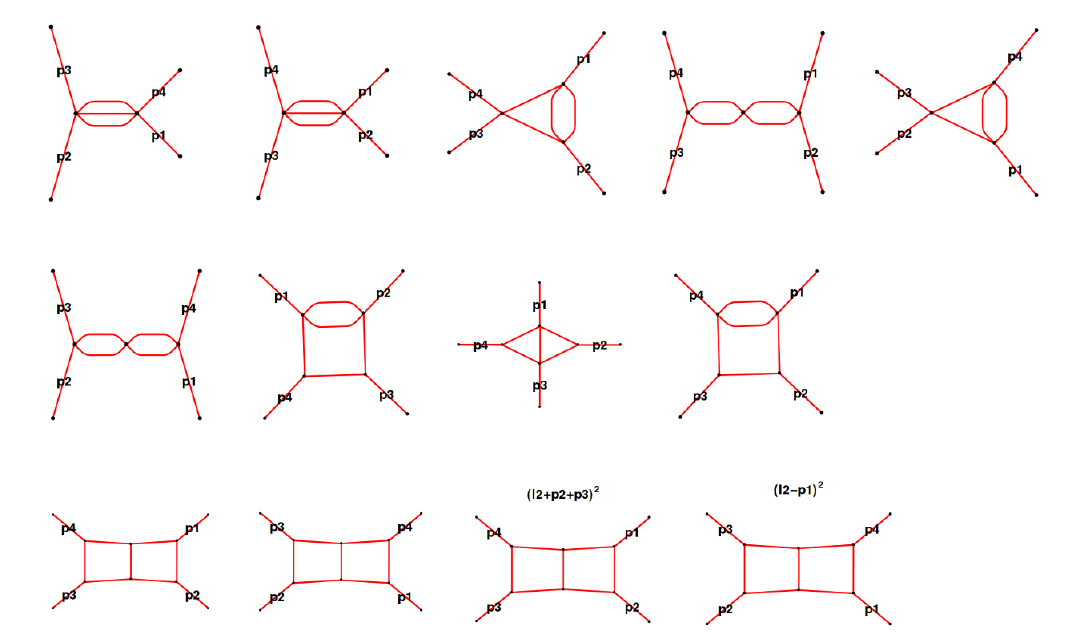
Figure 5 . Master integrals for four-point two-loop planar amplitude in pure Yang-Mills theory. The last two master integrals contain